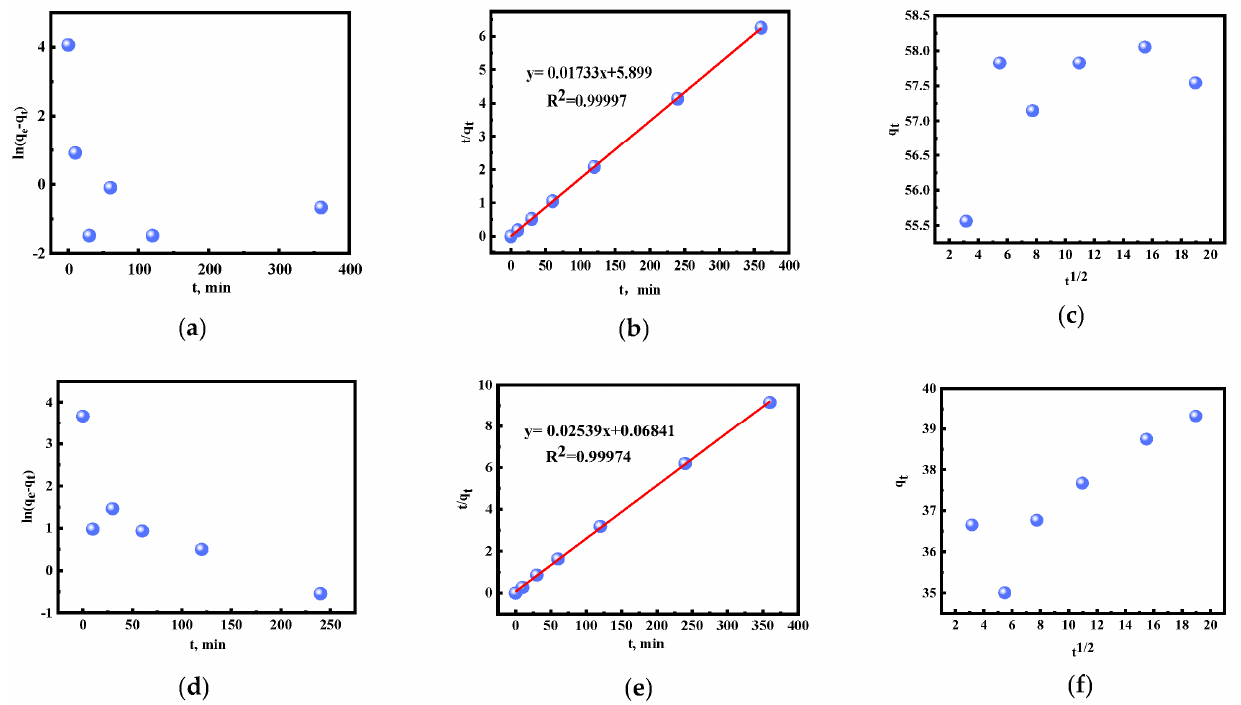
Figure 8. The fitting curves of UiO − 66 and [HMIm] + [BF 4 ] − @UiO − 66: ( a – c ) UiO − 66; ( d – f )